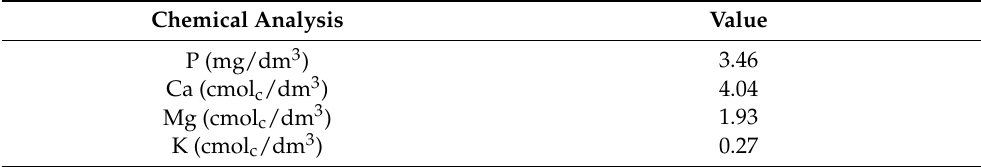
Table 1. Read chemical analysis of the soil